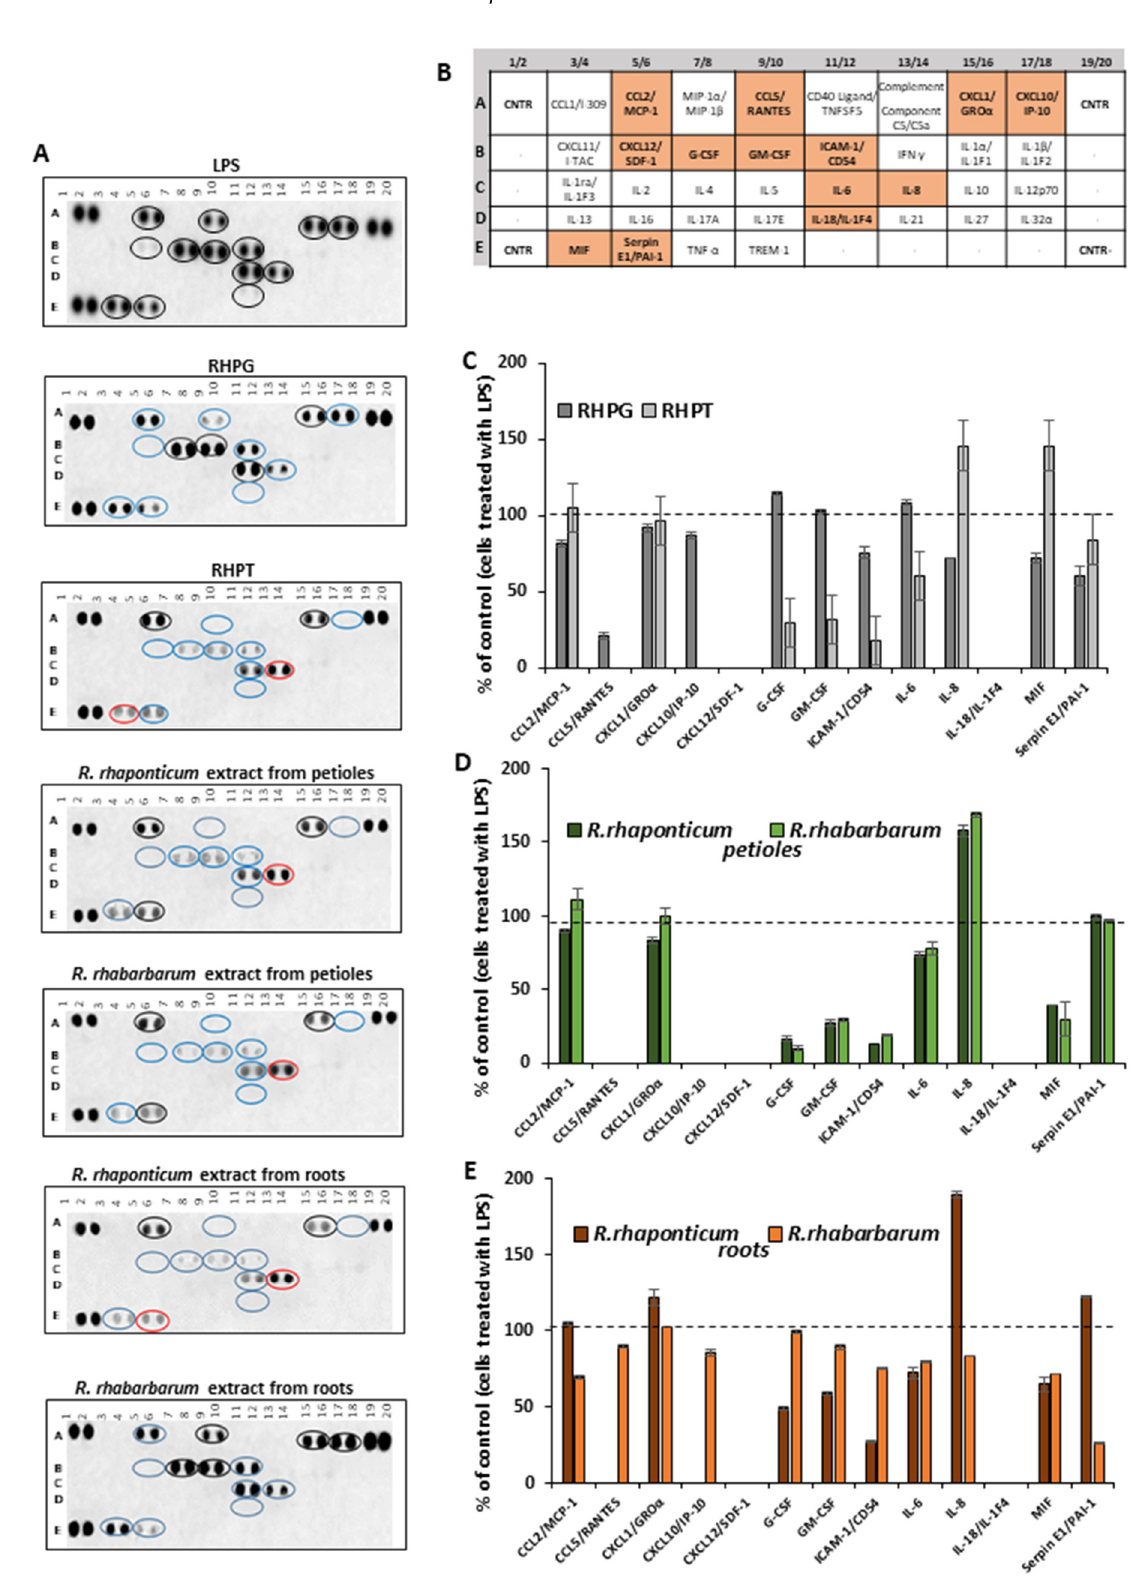
Figure 3. Effects of the examined rhubarb extracts and stilbenes on the HUVEC cytokine